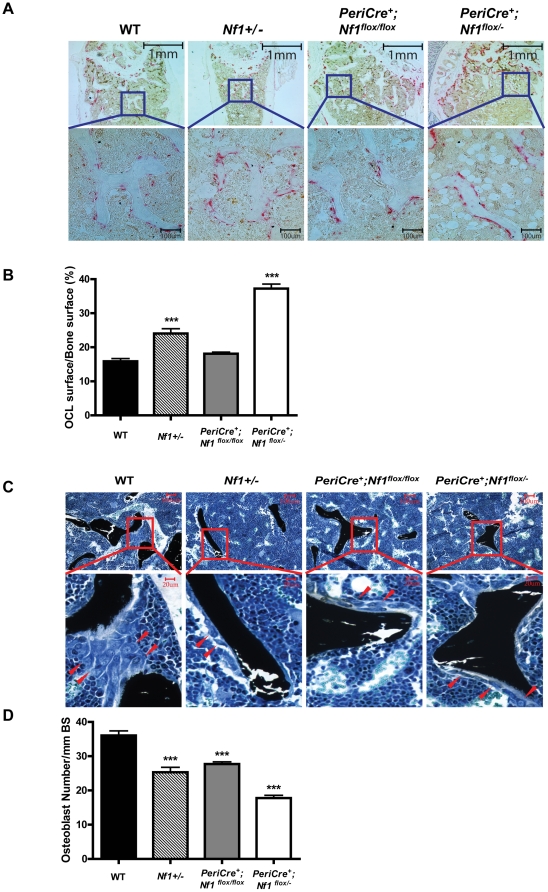

PeriCre+;Nf1flox/− mice have increased osteoclasts and decreased osteoblasts in vivo.(A) TRACP staining revealed a significant increase of osteoclasts in PeriCre+;Nf1flox/− mice. Representative photomicrographs shows TRACP+ osteoclasts in tibia of each mouse genotype (Red staining are TRACP positive osteoclasts). (B) Quantitative data showing the change of surfaces/BS ratio. ***P<0.001 for Nf1+/− and PeriCre+; Nf1flox/− VS WT controls. (C) Representative photomicrograph showing MacNeal staining of the tibia of each mouse genotype (Red arrow heads are pointing to osteoblasts). (D) Quantitative data showing the osteoblast number in trabecular bone/ mm BS. ***P<0.001 for . WT control vs PeriCre+;Nf1flox/− , Nf1+/− and PeriCre+;Nf1flox/flox mice.